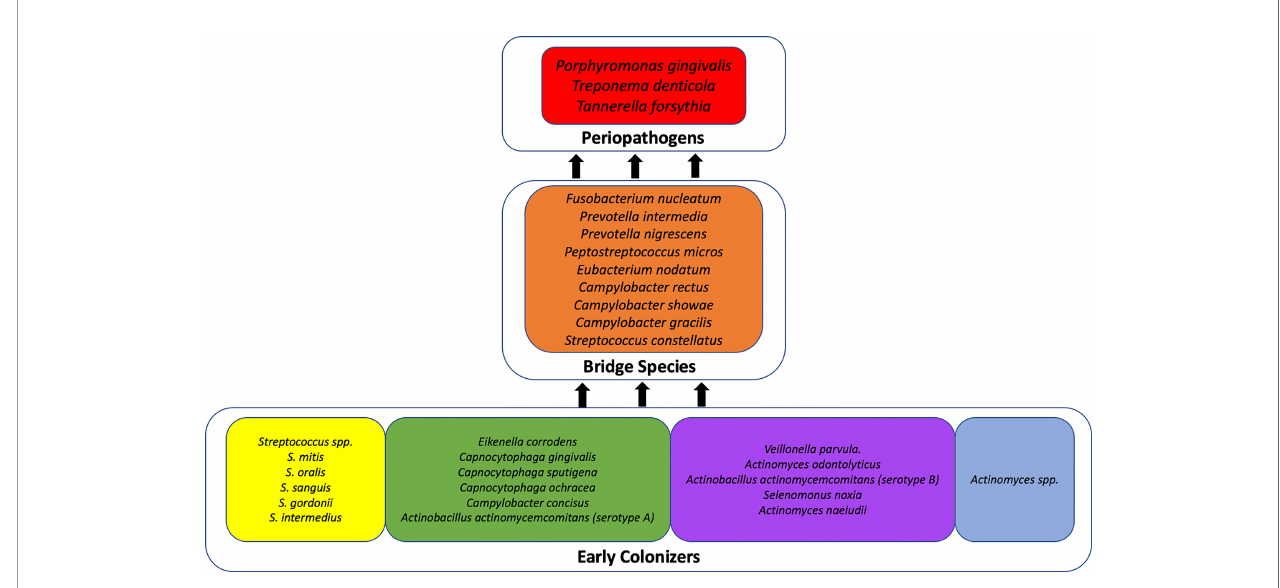
FIGURE 4 | Theoretical scheme of microbial succession in periodontal disease. This fi gure has been adapted from Socransky and Haffajee, 2005; Publisher: Wiley; Copyright © Blackwell Munksgaard